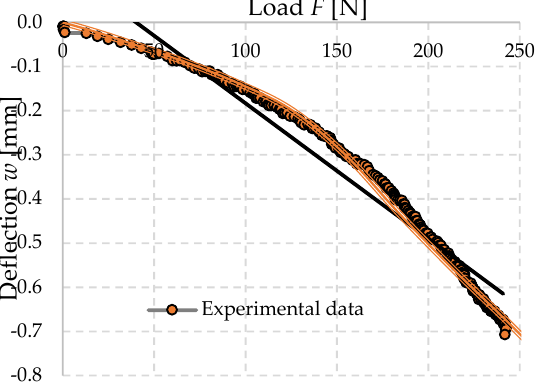
Figure 22. Example of FEM results–main normal stress σ 1 redistribution–longitudinal-section, load F = 280 N.